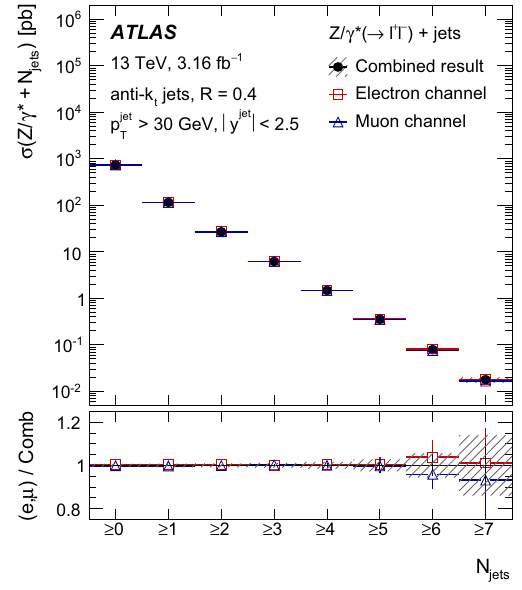
Fig. 3 Measured fiducial cross section as a function of the inclusive jet multiplicity ( left ) and the leading jet p T for inclusive Z + ≥ 1 jet events ( right ) in the electron and the muon channels and compared to their combined value. The ratios of the two measurements to the